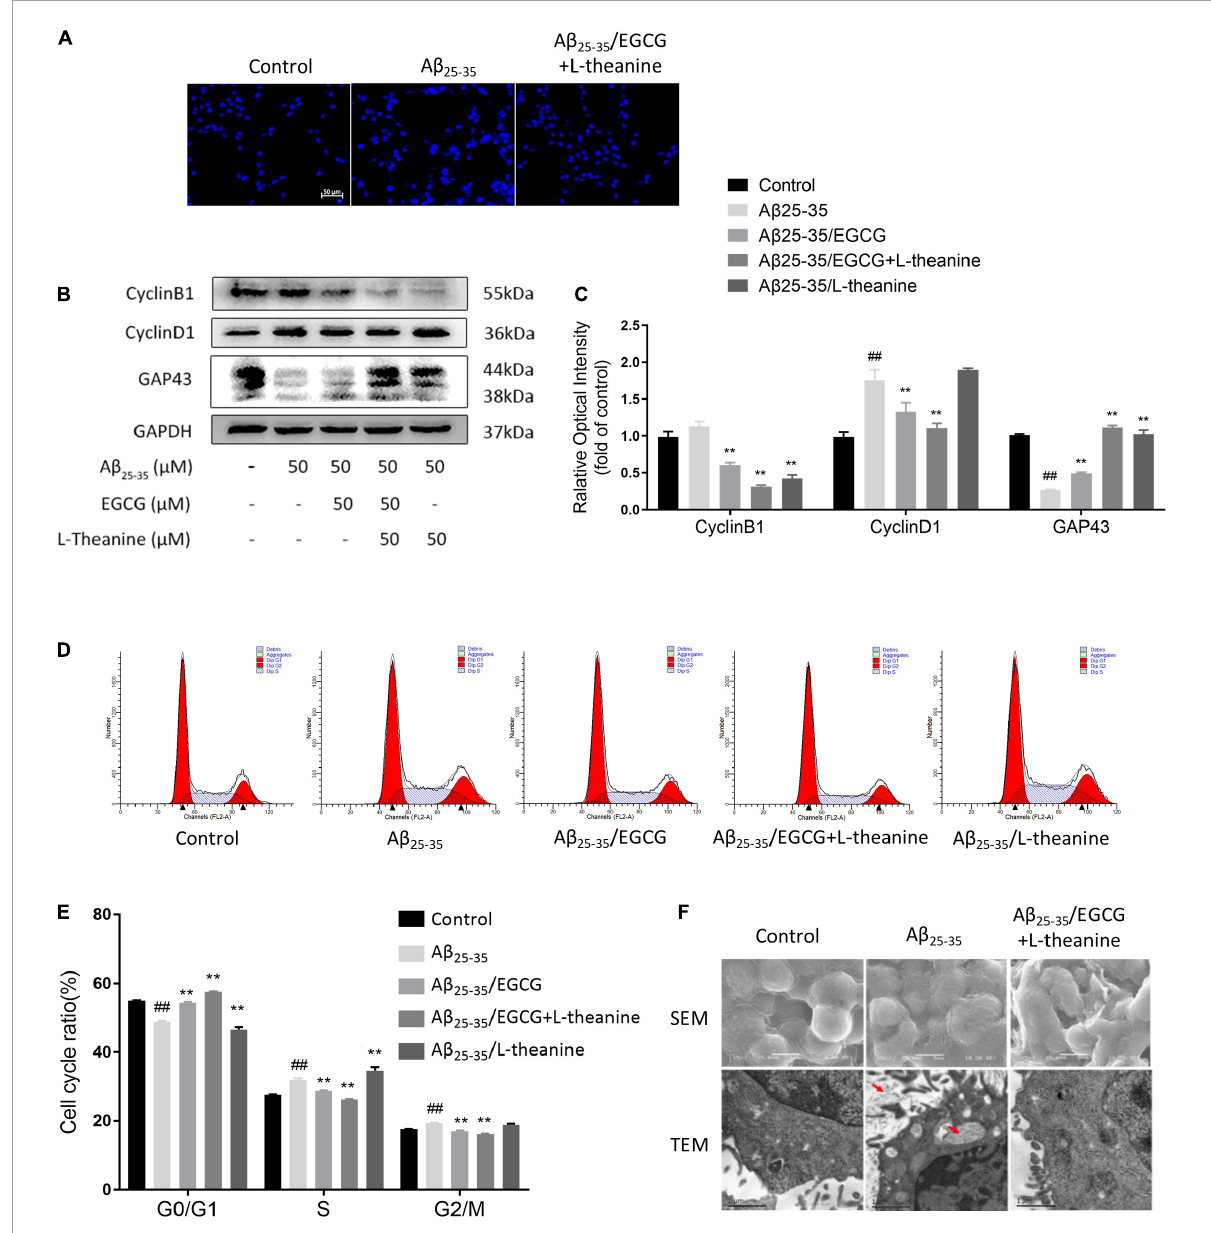
FIGURE4 EGCG + L -theanine regulates cell cycle and promotes axonal growth. (A) DAPI nuclear staining observation (bar = 50 µ m). (B,C) Western-blotting detection of Cyclin B1, Cyclin D1, and GAP43. (D) Flow cytometry analysis of cell cycle and apoptosis. (E) Statistical analysis of cell cycle. (F) Scanning electron microscopy (SEM) and transmission electron microscopy (TEM) analysis (red arrows point to the cellular fibrous aggregate fraction). ## p < 0.01, compared with control group; ** p < 0.01, compared with A β 25 − 35 group, n = 3.